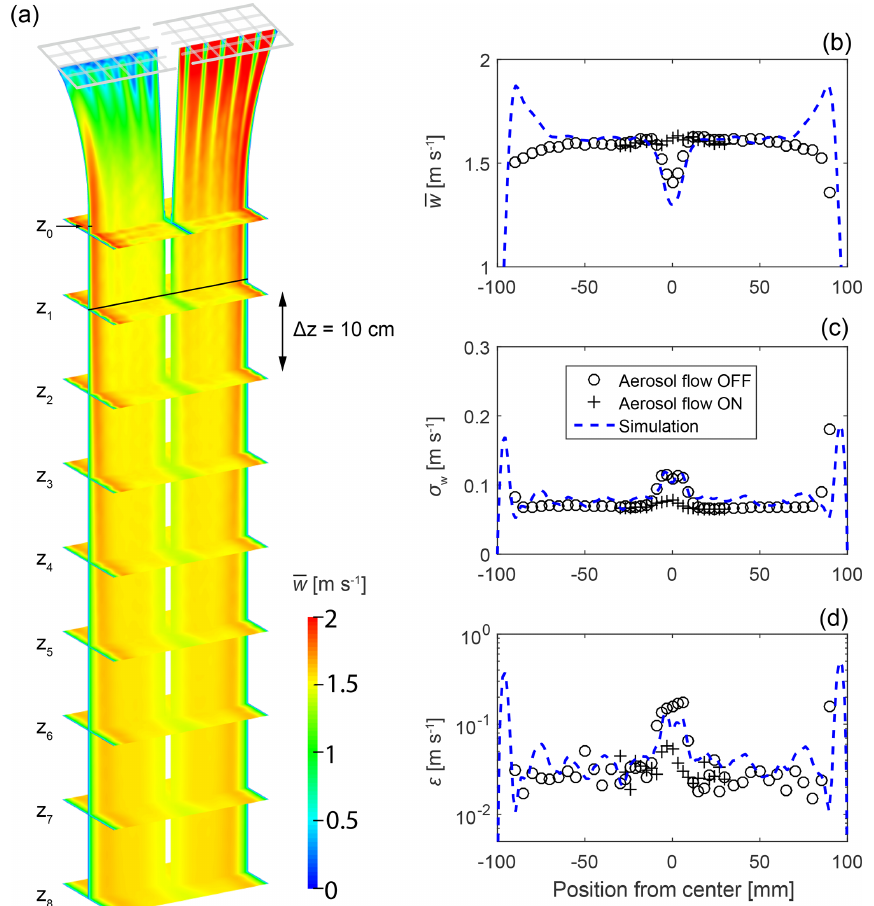
Figure 4. (a) Contour plot of the time-averaged velocity in two vertical and nine horizontal planes determined by the LES. The grid is also indicated. Note that the aerosol flow is turned off in the simulations. (b) Profiles of mean velocity w , rms velocity σ w and energy dissipation rate ε along the center region (black line in (a) ; position 0mm corresponds to the center of the measurement section depth, being 100mm away from each side wall) at z 1 = 10cm. The results presented are based on hot-wire measurements (at 6000Hz) performed in the central position of the measurement section underneath the middle of the grid openings. Measurements were taken with turned-on (crosses) and turned-off (open circles) aerosol flow. Corresponding simulation results for w and σ w are shown as blue dashed lines, for turned-off aerosol flow